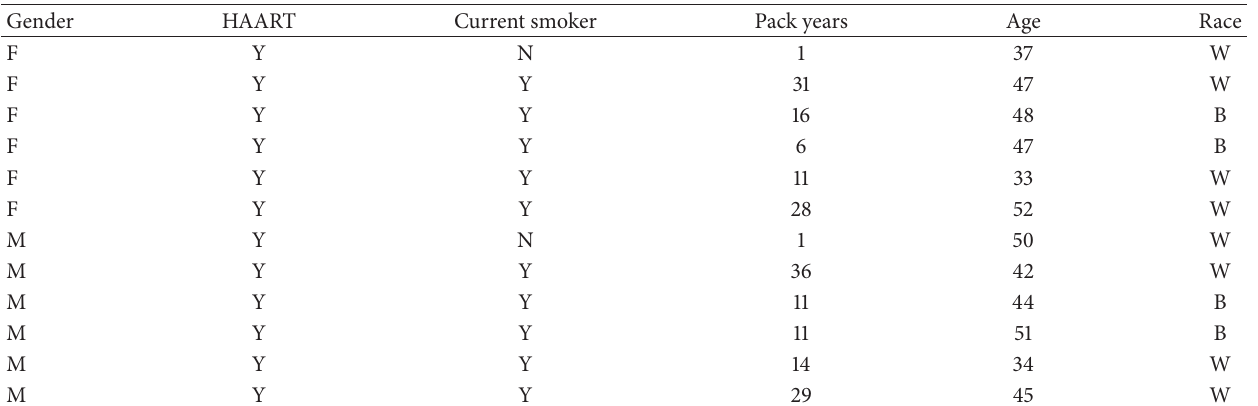
Table 3: Clinical characteristics of subjects undergoing bronchoalveolar lavage with alveolar macrophage proteomic analysis. Gender HAART Current smoker Pack years Age